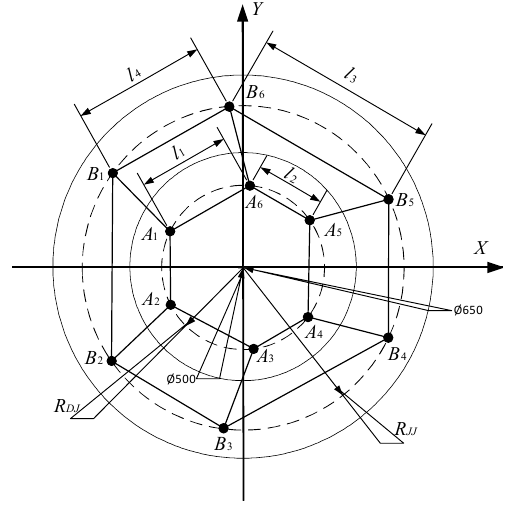
Figure 3. Schematic diagram of dimensions of upper and lower platforms and location of hinge points.